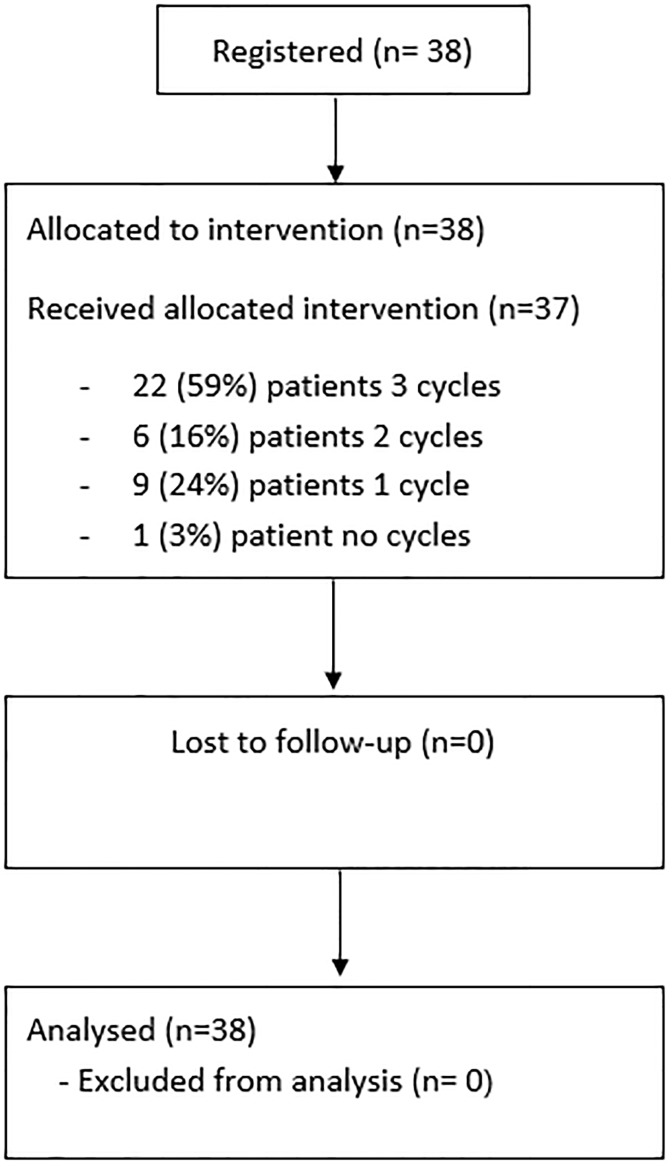
CONSORT diagram.